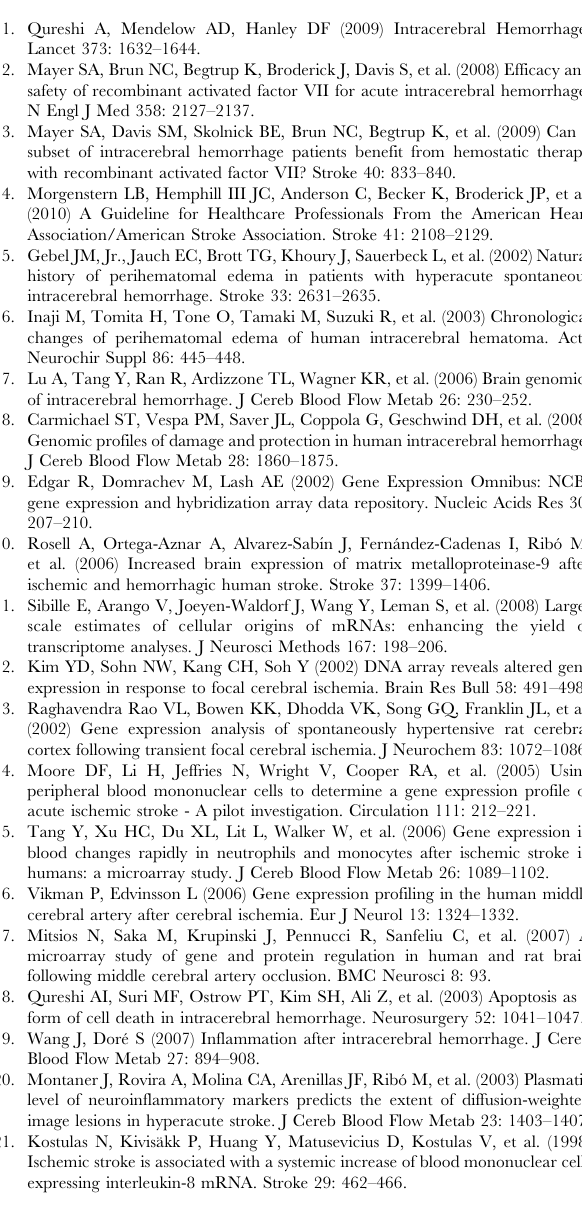
Table S1 Group of genes identified to be Neuronal or Glial markers in healthy brain tissue and expression patterns. Table S2 Complete list of significantly regulated genes between perihematomal and contralateral areas